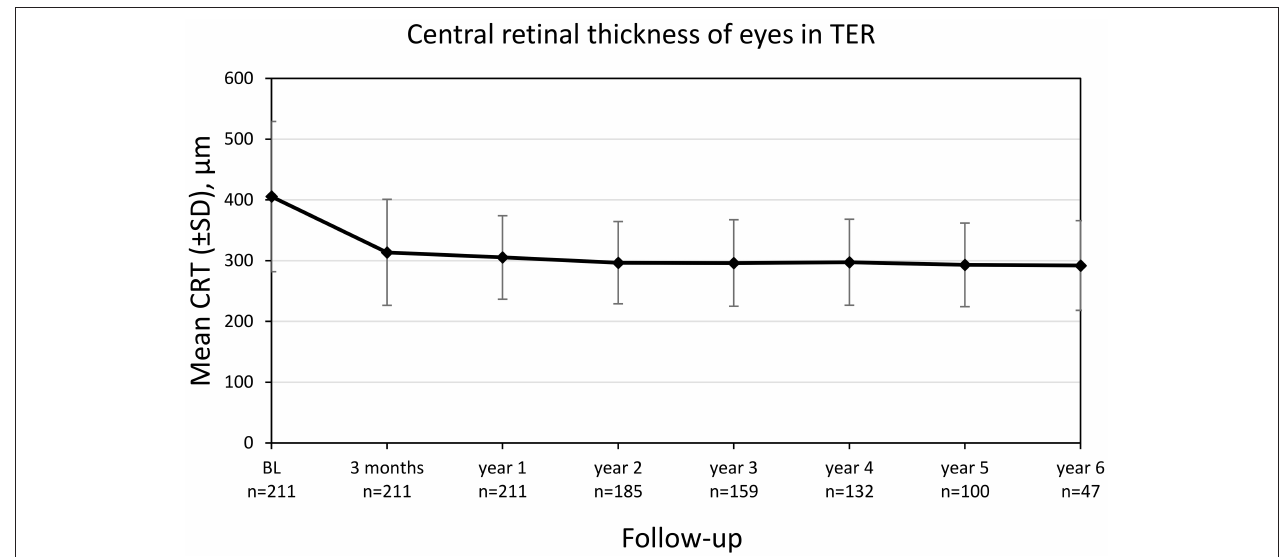
FIGURE 5 | Central retinal thickness (CRT) of eyes treated in TER from baseline to year 6. Values are shown as mean ± SD, standard deviation.